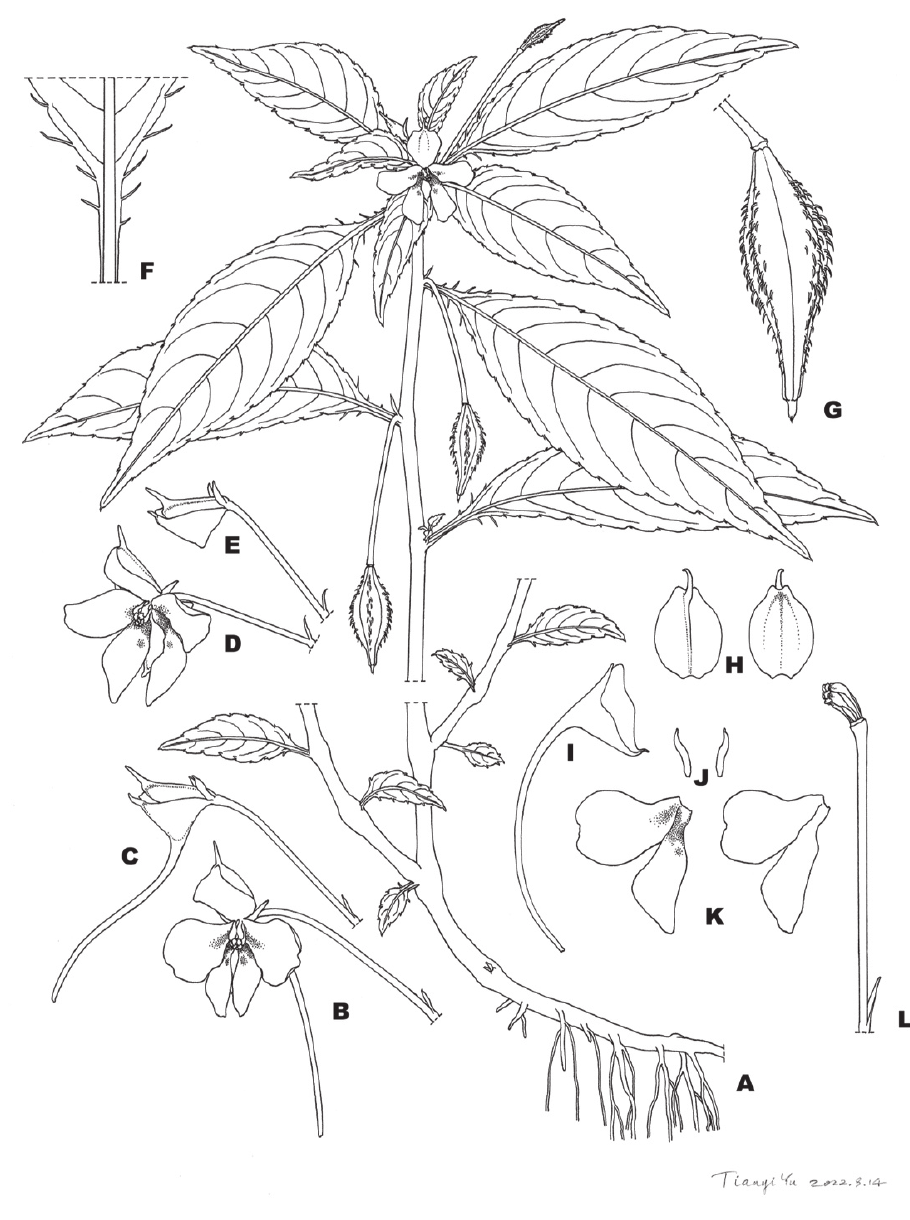
Figure 2. Impatiens chenmoui sp. nov. A habit B, C flower with long spur D, E flower with spur nearly absent F leaf base G capsule H dorsal petal I spur J lateral sepals K united lateral petals L ovary sur- rounded by